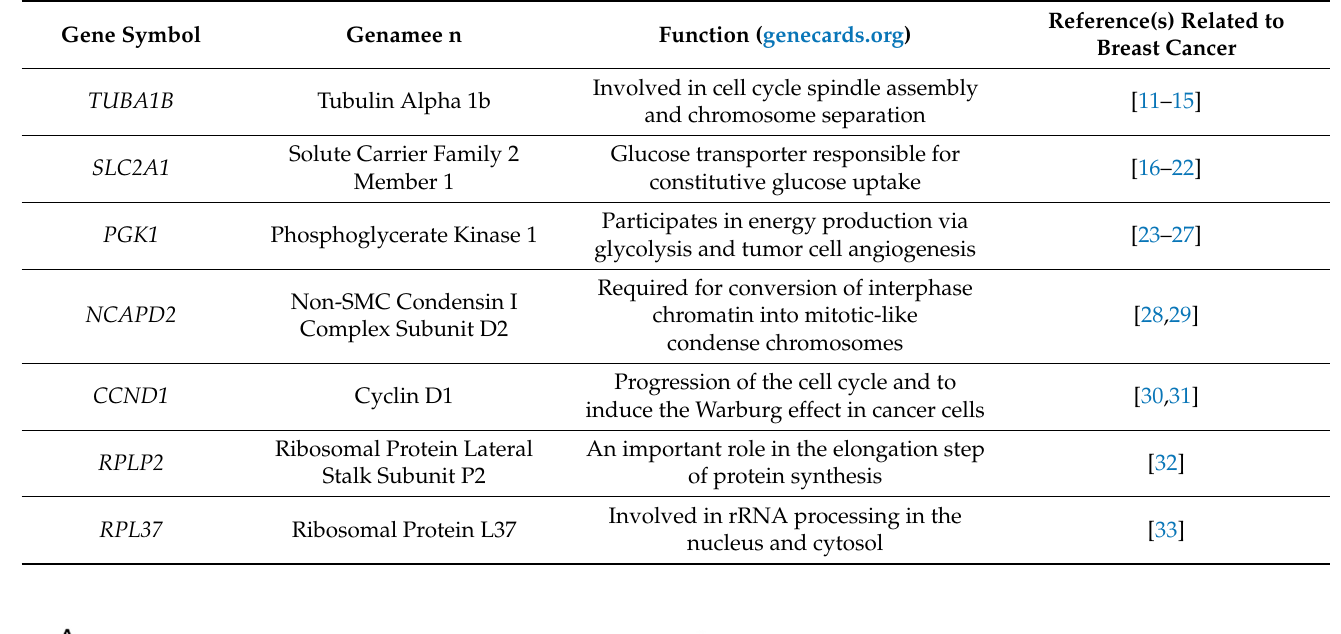
Table 1. Details of the genes highly likely to be epigenetically regulated in crocodile serum treated breast cancer cells.